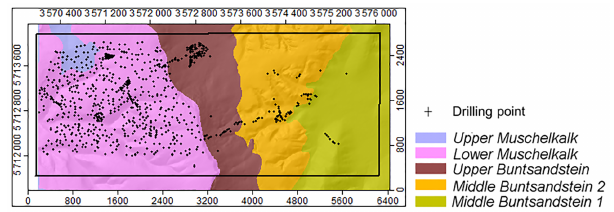
Figure 10. Drilling points ( n = 1141) from LBEG soil profile database on the simplified geological units within the validation